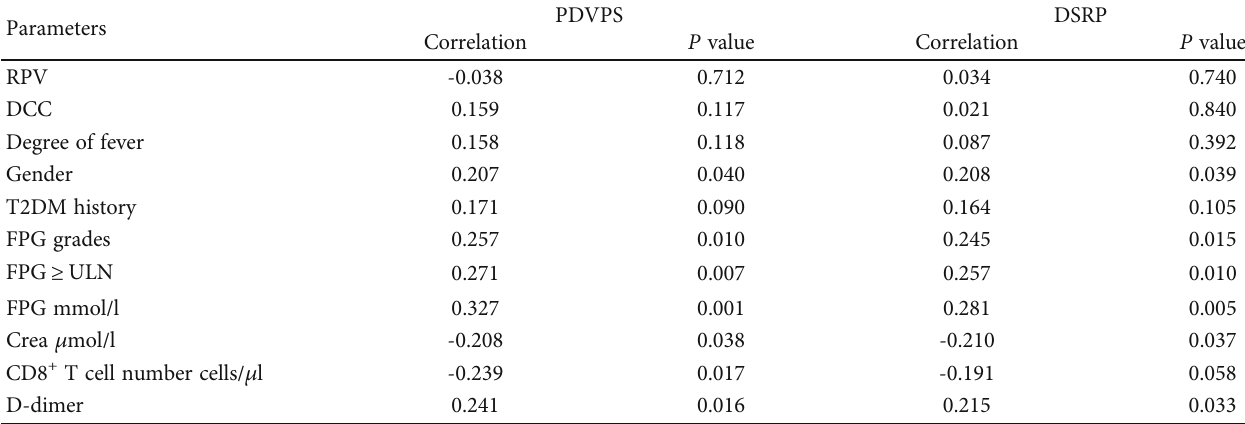
Table 3: Spearman ’ s correlation between PDVPS/DSRP and other